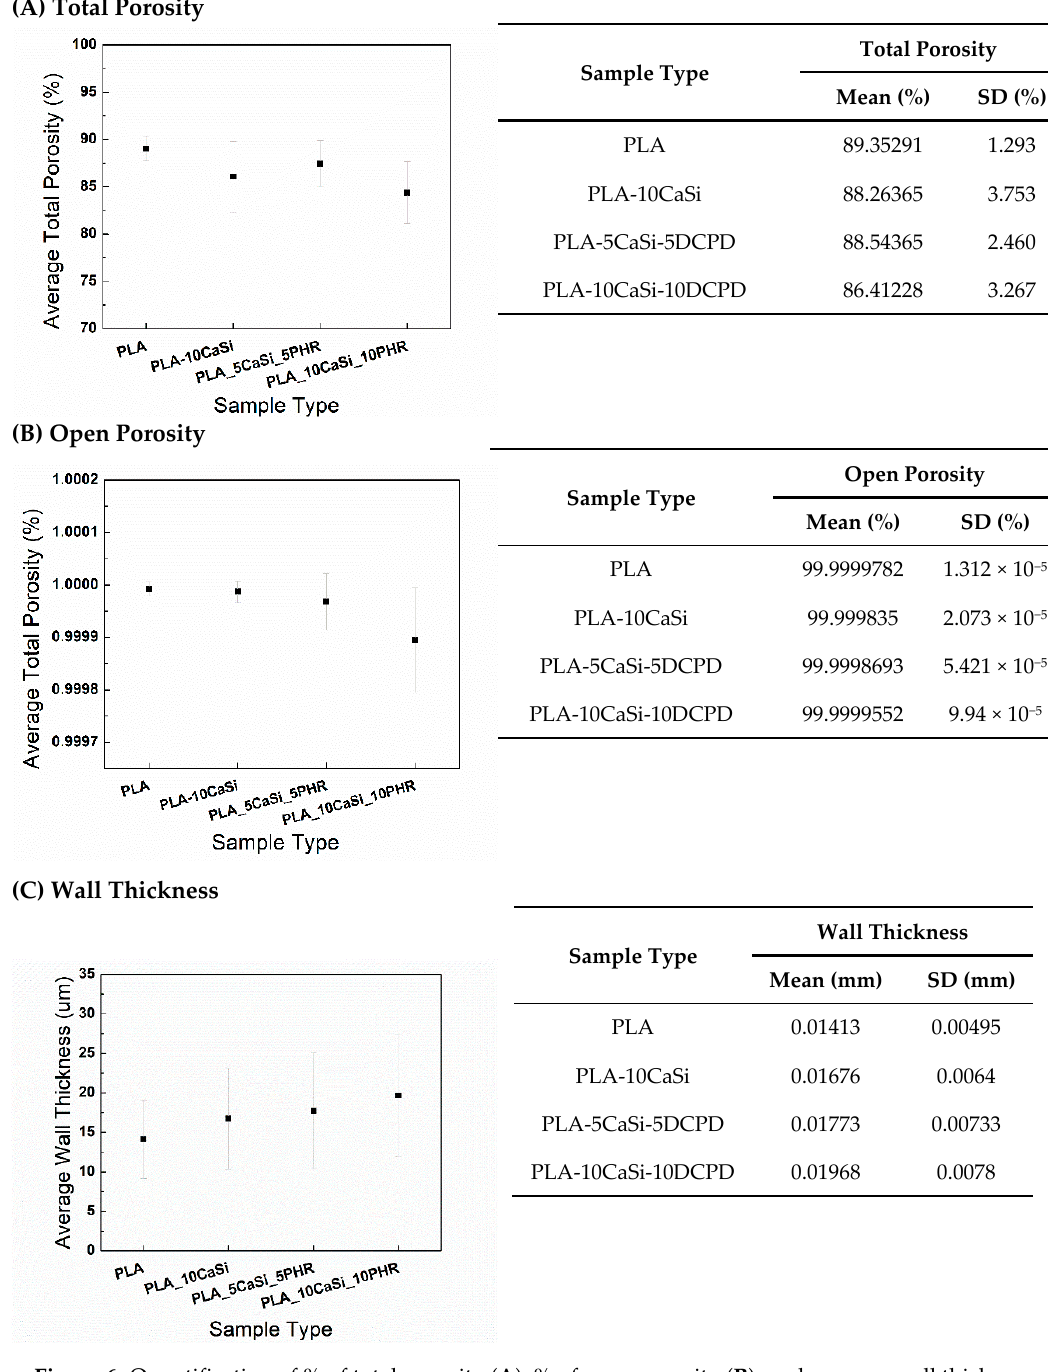
Figure 6. Quantification of % of total porosity ( A ), % of open porosity ( B ), and average wall thickness of the pores ( C ) from the micro-CT scanned samples of all different scaffolds.